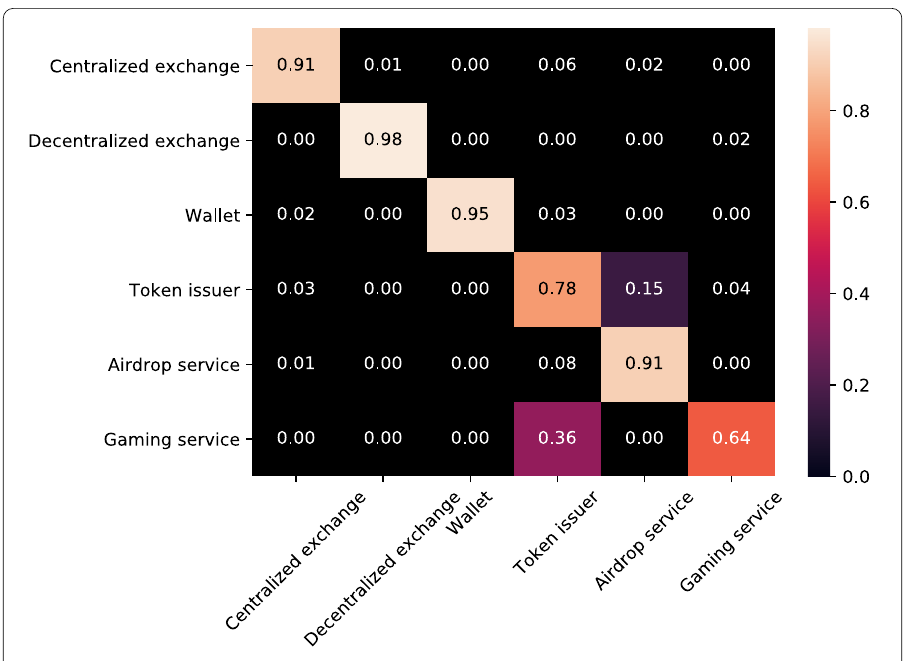
Figure 3 The confusion matrix of the random forest classifier predictions. Rows are the labels of samples and columns are the predicted identities. Exchanges and wallets can be perfectly distinguished from other agents while token issuers may be confused with airdrop services, and gaming services may be confused with token